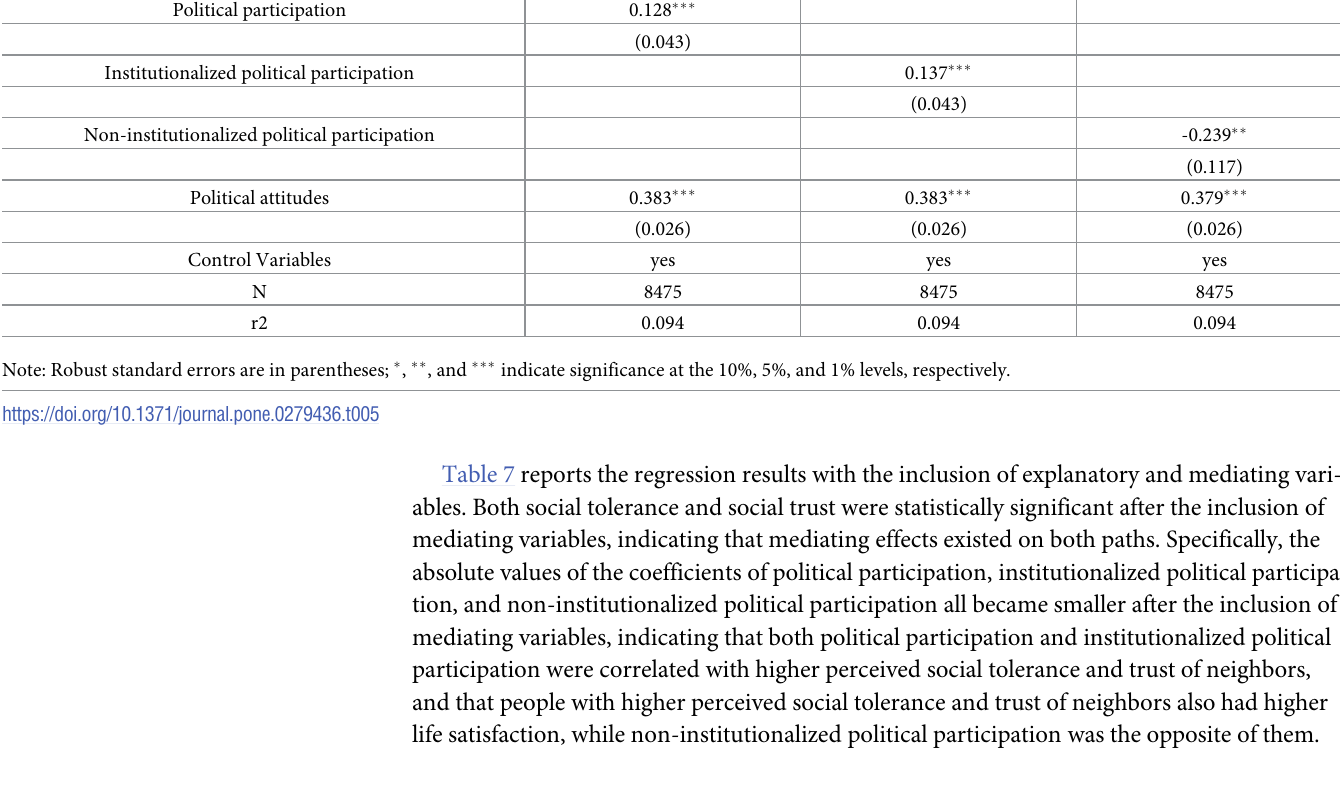
Table 5. Regression results controlling for political attitudes.